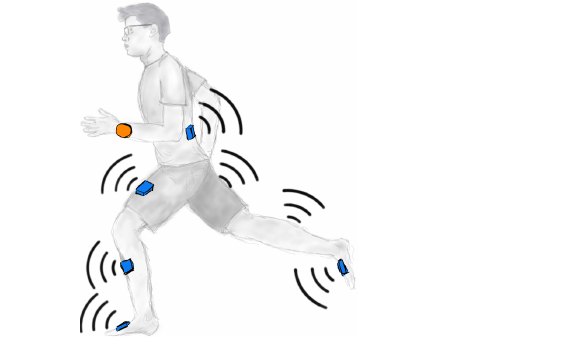
Figure 2. The human gait is assessed using a wearable wireless inertial sensor network consisting of seven sensors (blue) and one receiver (orange).